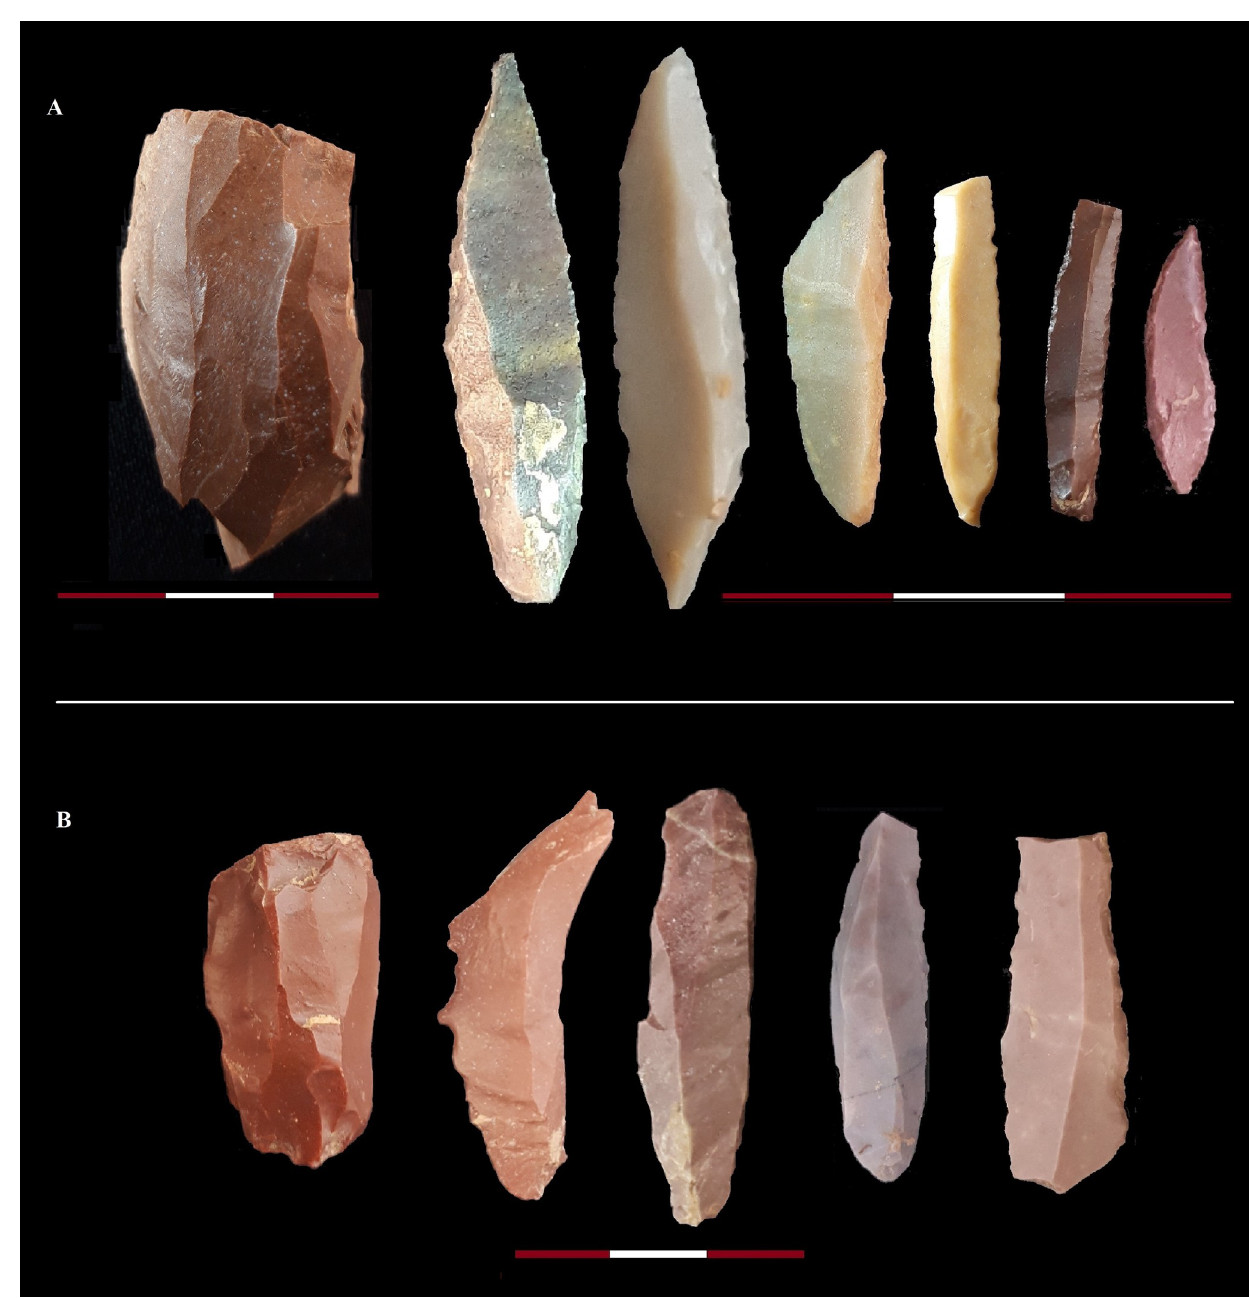
Fig 7. A: 1. Platform bladelet core, 2, 3. points on bladelet, 4, 5. Geometric microliths, 6,7. Retouched bladelets. B:1. platform bladelet core, 2. Denticulated bladelet, 3, 4. Twisted bladelets, 4, 5. Retouched twisted bladelets.